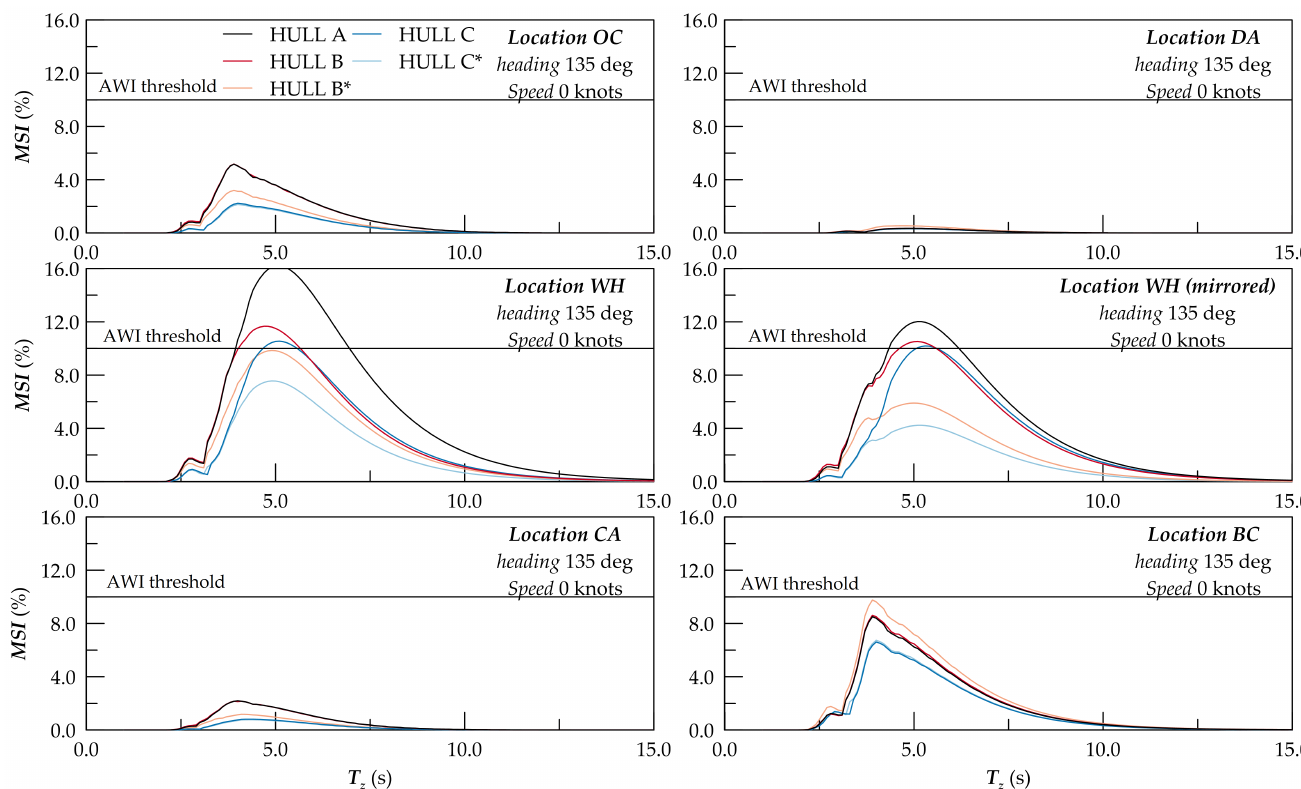
Figure 20. MSI values for H s = 1.5 metres at different T z for the AWI 22834 locations at 0